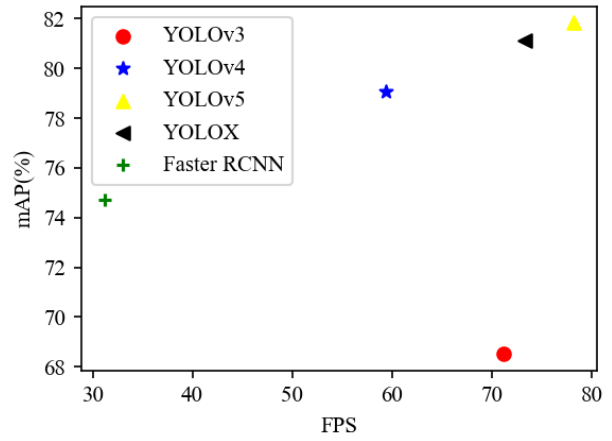
Figure 5. Performance comparison of multiple target detection networks. The horizontal axis FPS is the abbreviation of the frames per second, which indicate the operating speed of the algorithms.